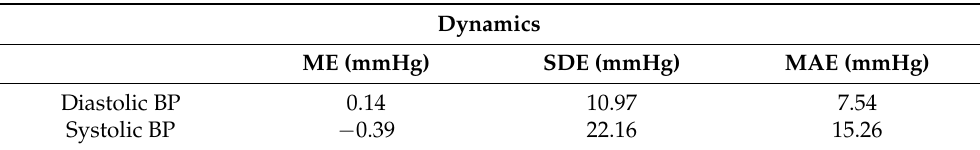
Table 3. Blood pressure estimation performance using IBI features from 30 PPG waveforms. Five features are used for DBP and four are used for SBP. Estimation is carried out using the ANN described in the text, and the results are averaged over the 30 patients.